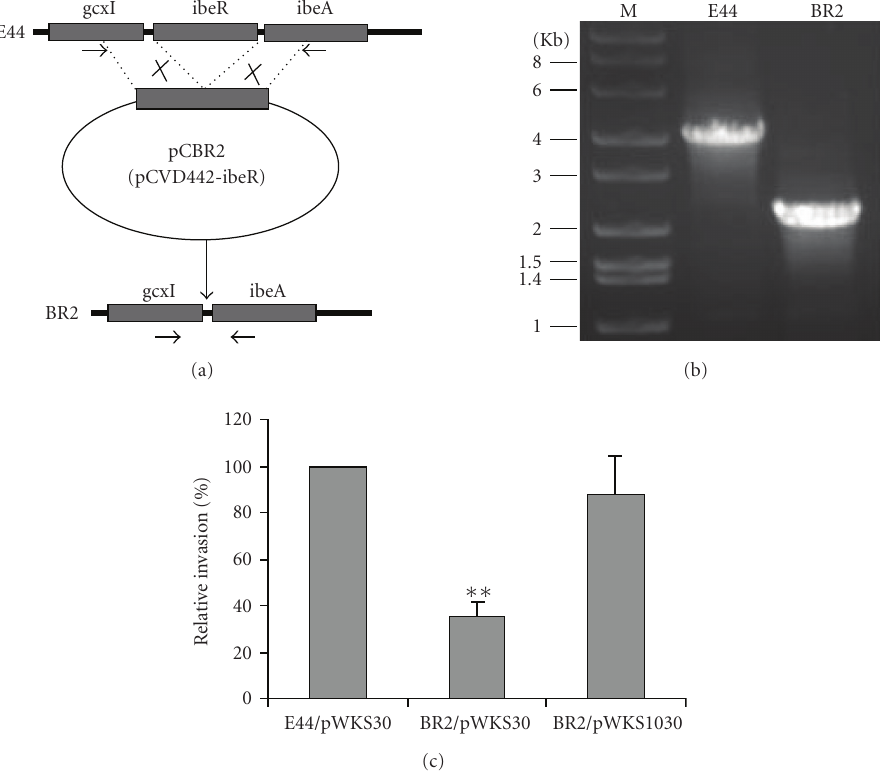
Figure 1: Generation and characterization of ibeR deletion mutant from the meningitic strain E44 . (a) Generation of the ibeR deletion mutant (BR2). Two DNA fragments flanking ibeR were amplified and ligated into the suicide vector pCVD442 to construct pCBR2. The ibeR deletion mutants were generated through gene allele exchanges and suicide vector loss. The arrowheads indicate primer locations. (b) Verification of the ibeR deletion by PCR. The parent strain E44 and the ibeR deletion mutant BR2 were verified though colony PCR with primers listed in Table 2. (c) Invasion of HBMEC with the E. coli parent E44 carrying pWKS30, the ibeR mutant BR2 with pWKS30, and the complemented BR2 carrying the ibeR locus in pWKS30. E44/pWKS, BR2/Pwks, and BR2/pWKS1030 were incubated with HBMEC monolayers and the standard invasion assay was carried out as described in Section 2. The results are expressed as relative invasion%. Columns marked with ∗∗ are significantly di ff erent ( P < .